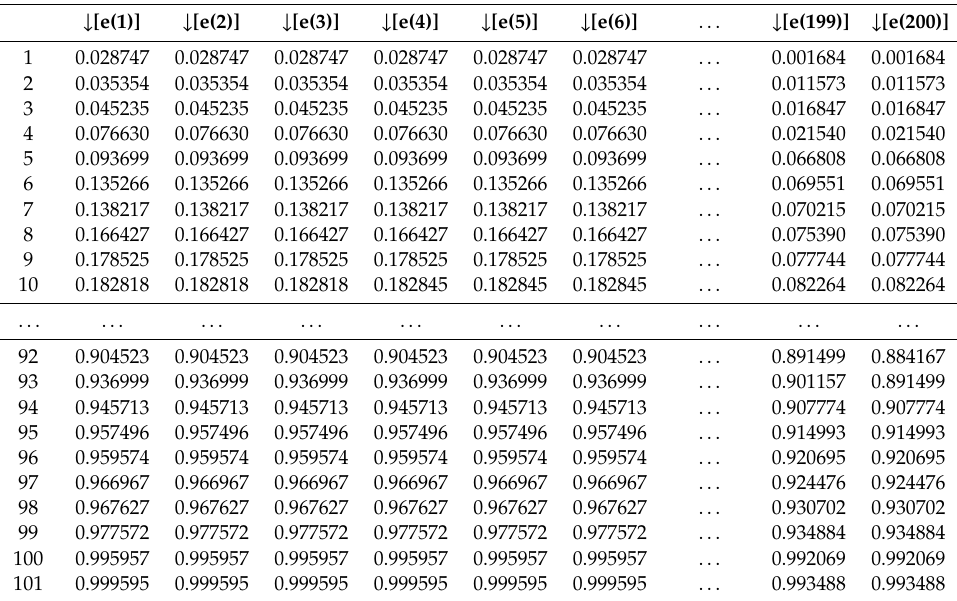
Table 3. Sorted random numbers ↓ [e( i )], i ∈ [1, 200].